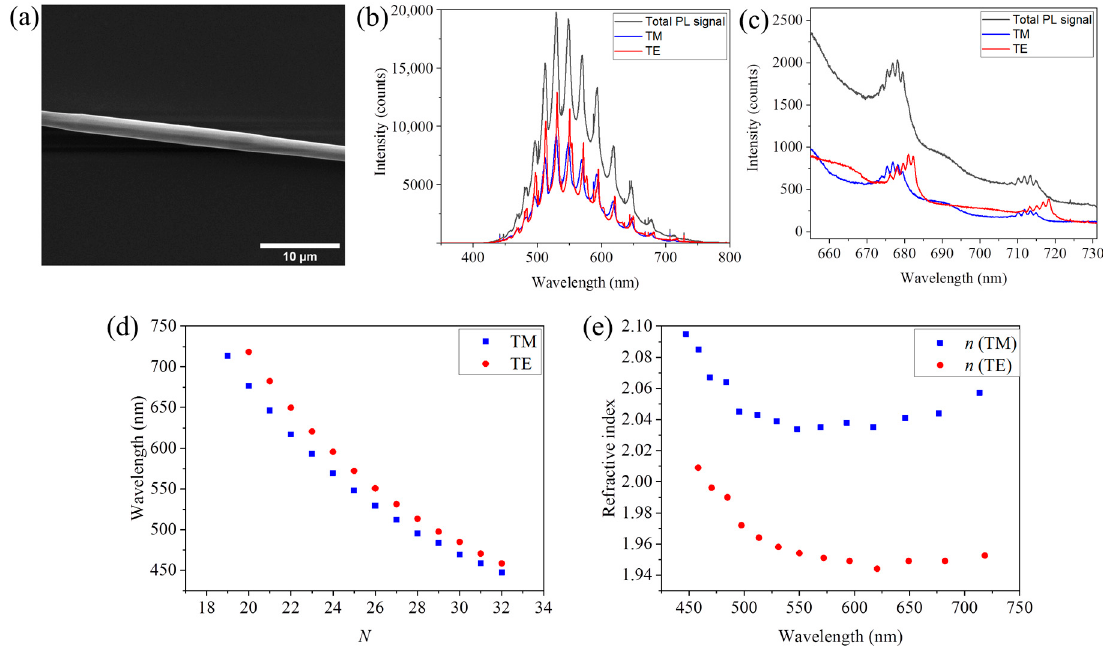
Figure 10. Analysis of the whispering gallery modes in region (iii). The measured length side “a” measured in the ( a ) SEM images was 1.39 µ m. ( b ) µ -PL spectra for all the polarization conditions and spectra ( c ) shows a detailed second set of resonant peaks from the Fabry-P é rot modes. ( d ) Interference order N of the peaks observed in the spectra. ( e ) Estimation of the refractive index from the wavelength. Due to the thicker section in this structure, the calculated refractive indexes were less accurate, showing a higher di ff erence for both polarizations.